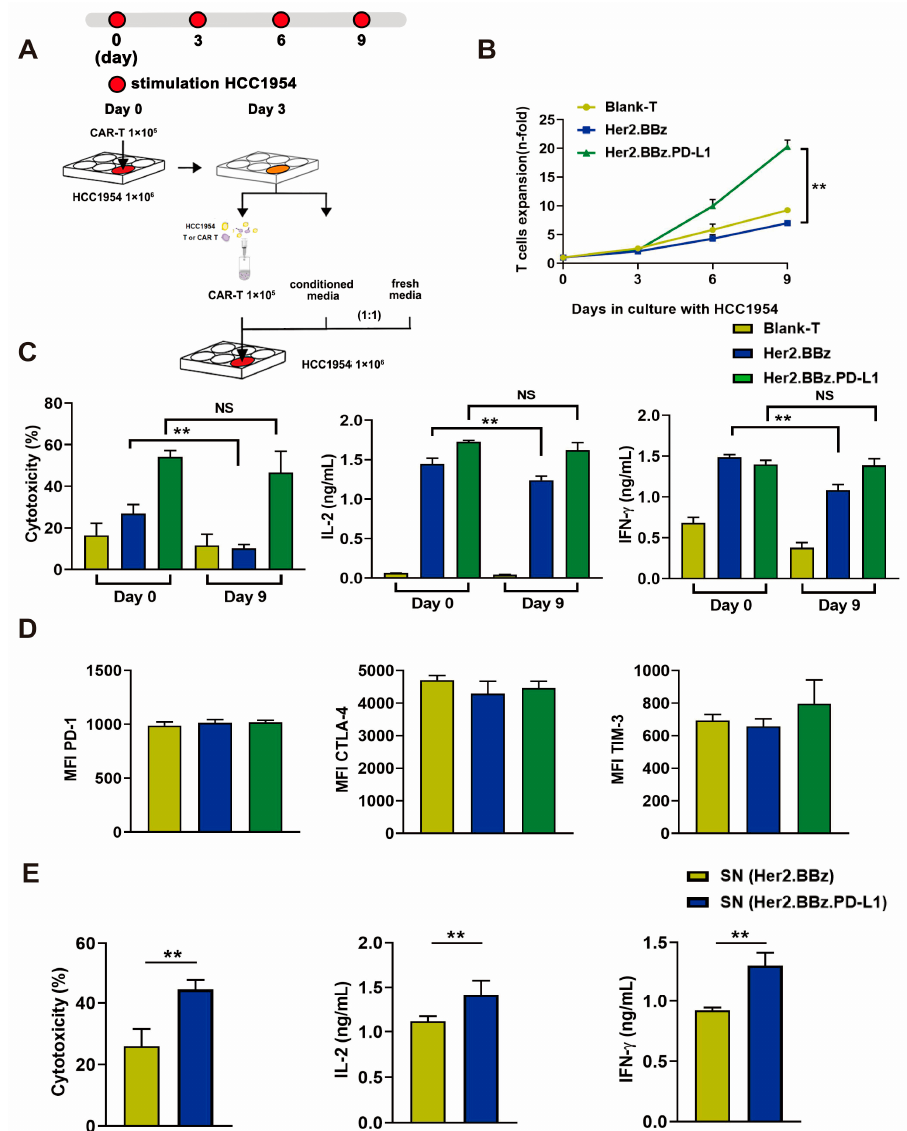
Figure 4. Effects of antigenic stimulation on cell exhaustion, cytotoxicity, cell proliferation, and cytokine secretion by bland T, Her2.BBz CAR T, and Her2.BBz.PD-L1 CAR T cells. ( A ) Scheme of the experimental procedure: 1 × 10 5 blank T cells and CAR T cells were co-cultured with 1 × 10 6 HCC1954 cells for 3 days. The culture supernatant (conditioned media) was collected and filtered. T cells were isolated by MACS CD3 microbeads, and 1 × 10 5 T cells resuspended in a medium containing equal amounts of conditioned medium and fresh medium, and co-cultured with 1 × 10 6 HCC1954 cells for another 3 days. This process was repeated one more time at day 6, and the cell exhaustion experiment lasted for 9 days in total. ( B ) During the prolonged antigenic stimulation, T cells were isolated by CD3 microbeads and analyzed for cell proliferation ( n = 3). ( C ) The cytotoxicity and the cytokine secretion were measured before (day 0) and after (day 9) antigen stimulation at the E:T ratio of 1:10 ( n = 3). ( D ) The expression of T cell surface markers PD-1, CTLA-4, TIM-3 was measured by flow cytometry, and MFI was calculated using FlowJo ( n = 3). ( E ) The effects of PD-L1